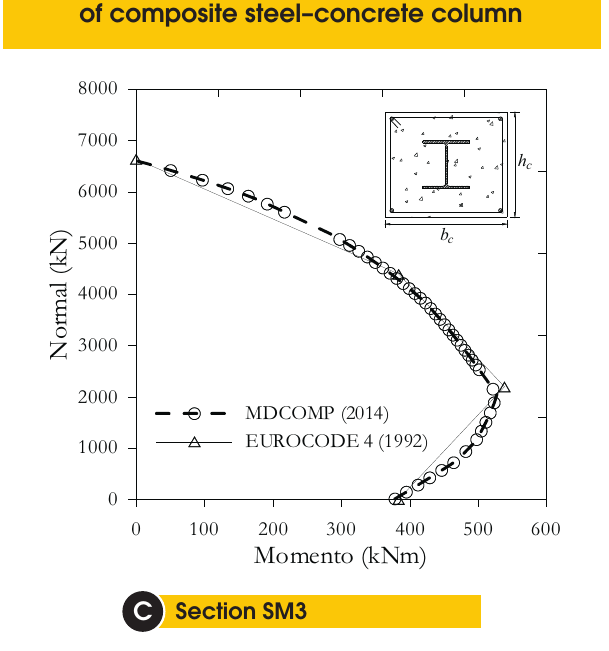
Figure 6c – Interaction curve of cross–sections of composite steel–concrete